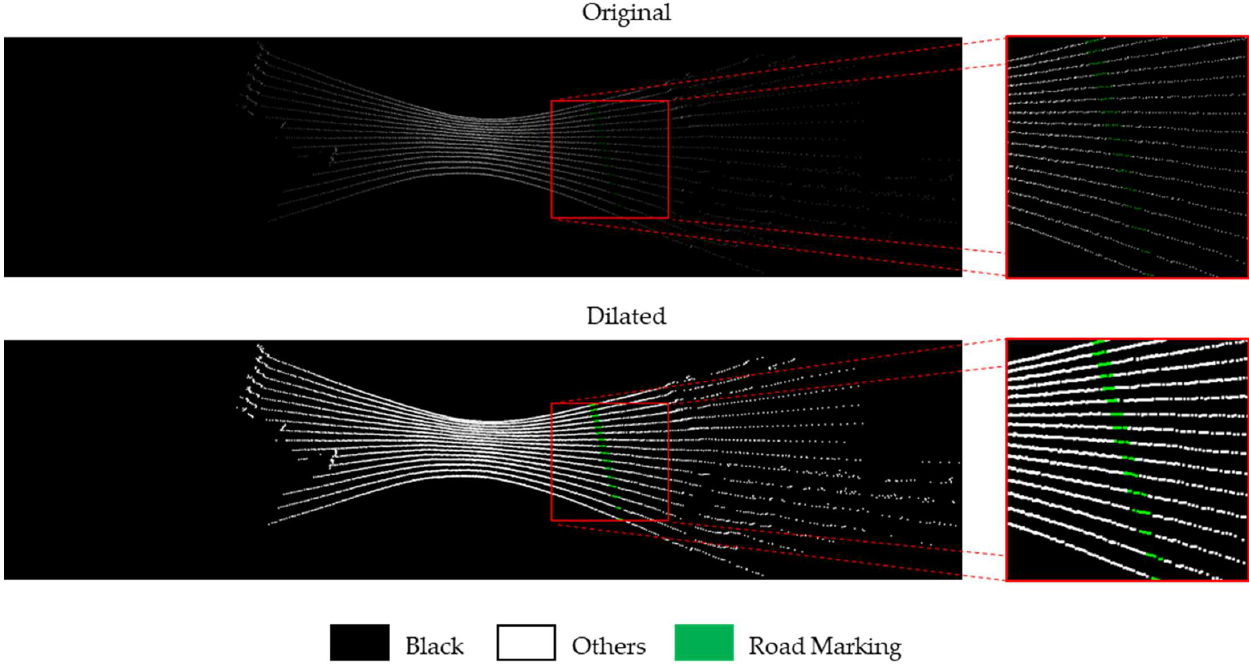
Figure 5. Sample image of the dataset ( top ) and dilated counterpart for visualization ( bottom ). The red square indicates the location of the detected road marking.